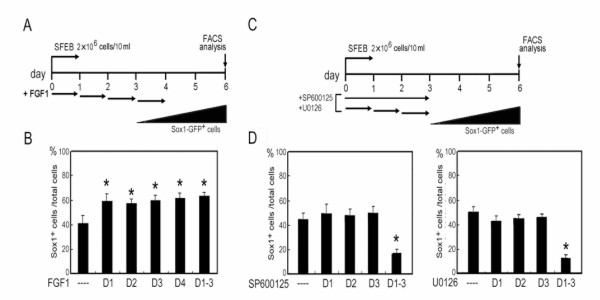
Response windows of FGF and MAPK inhibitors in differentiating ES cells. (A) FGF1 at 40 ng/ml was applied to 46C ES cells on individual days (D1, D2, D3, D4) or from day 1 through 4 (D1-4). (B) Derived GFP+ cells were analyzed by FACS on day 6. Independent experiments done in triplicate are illustrated. (C) As the indicated experimental conditions, the induction of Sox1-GFP+ cells on day 6 was shown in (D) after FACS analysis. SP600125 and U0126, 10 μM and 5 μM, respectively.